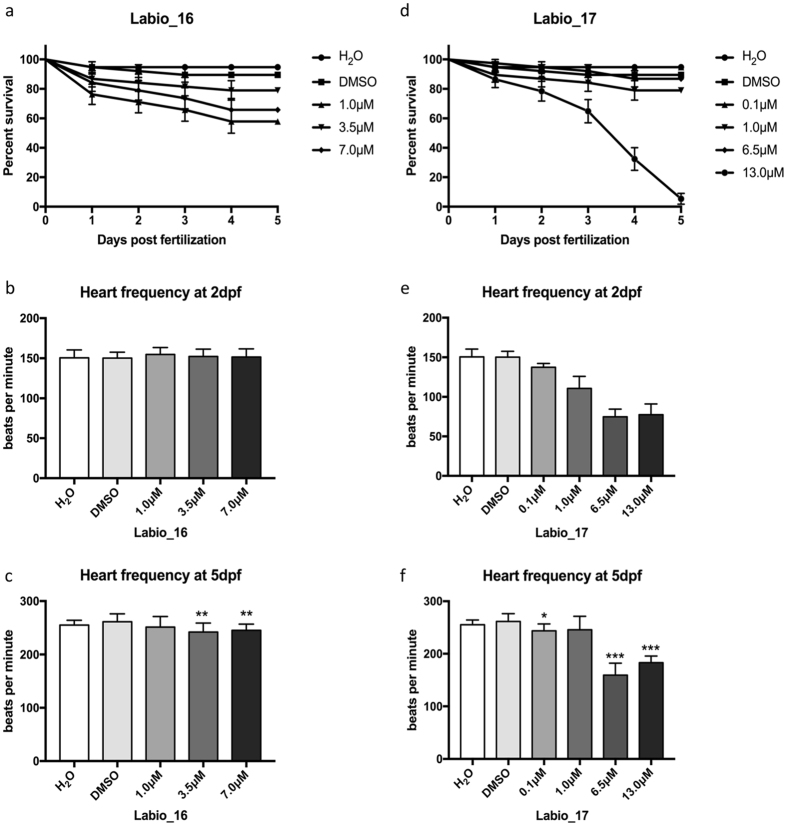
In vivo assay using Zebrafish embryos from 2 hpf to 5 dpf.Kaplan-Meyer survival curve was analysed during 5 days of treatment for both compounds Labio_16 (a) (Log-rank (Mantel-Cox) Test p = 0.0005), and Labio_17(d) (Log-rank (Mantel-Cox) Test p < 0.0001). Heart frequency was also evaluated at 2 dpf ((b), Laio_16; (e), Labio_17) and 5 dpf ((c) Labio_16; (f), Labio_17). Heart frequency was analysed using one-way ANOVA followed by Tukey post-hoc. (*p < 0.05 different from DMSO group; **p < 0.01 different from DMSO group; ***p < 0.001 different from DMSO and H20 groups. (Graphs were plotted with means and SD).